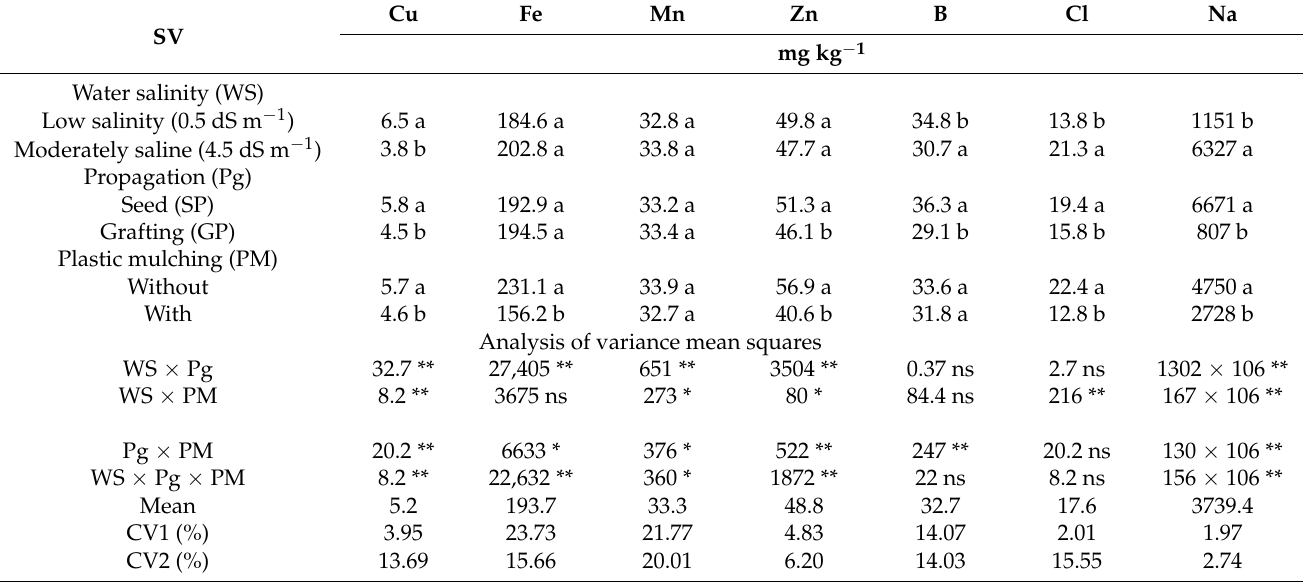
Table 2. Variance analysis summary and mean concentrations of copper (Cu), iron (Fe), manganese (Mn), zinc (Zn), boron (B), chlorine (Cl), and sodium (Na) in leaves of sour passion fruit plants as